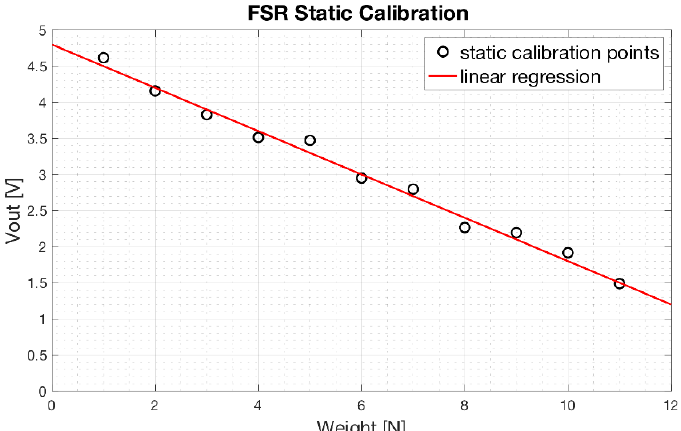
Figure 11. Static calibration of an FSR-based sensor used to measure phalanx contact force: scatter plot of the experimental data (black circles) and the regression line (red line).